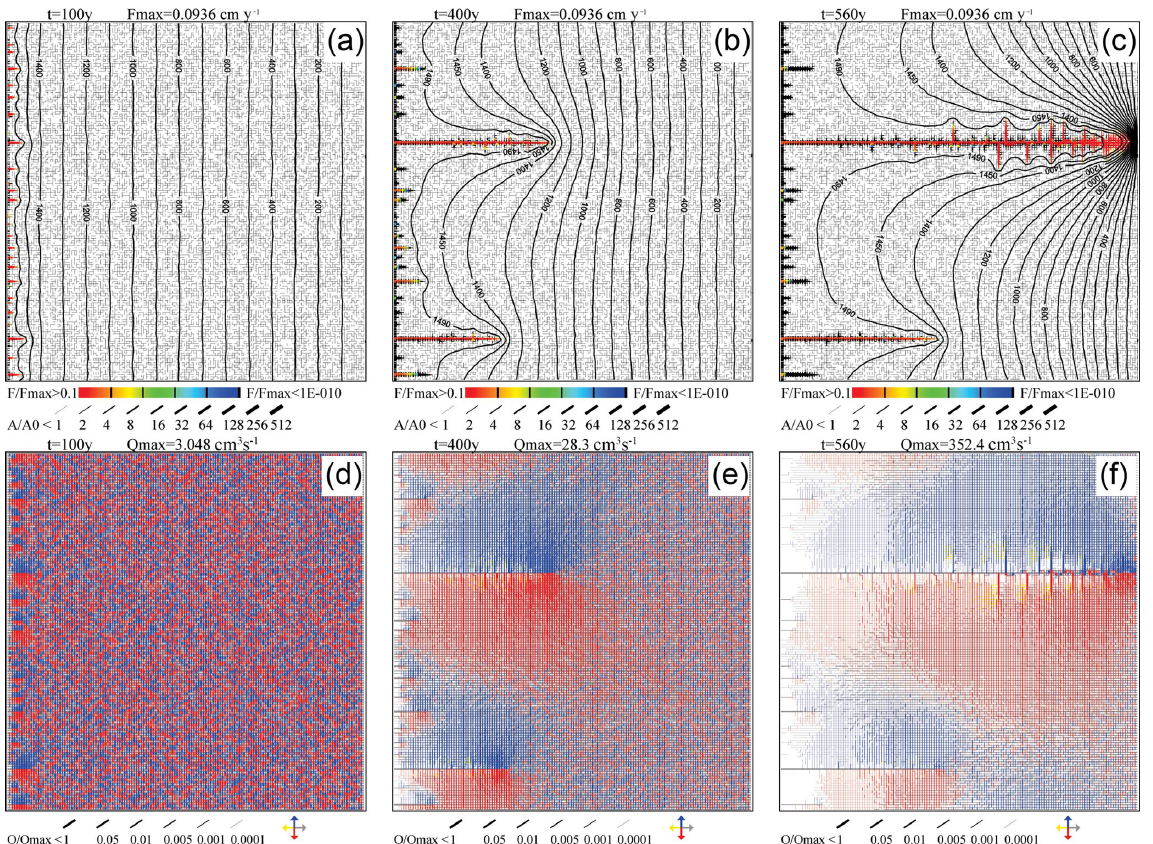
Figure 20. Evolution of wormholes in the network with lognormal distribution of initial aperture widths. (a–c) Aperture widths and dissolu- tion rates. (d–f) Flow rates and